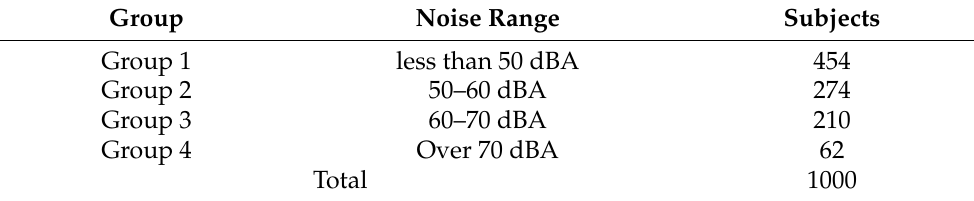
Figure 7. Combined noise map of the research area. Table 1. Scope of noise levels and the number of